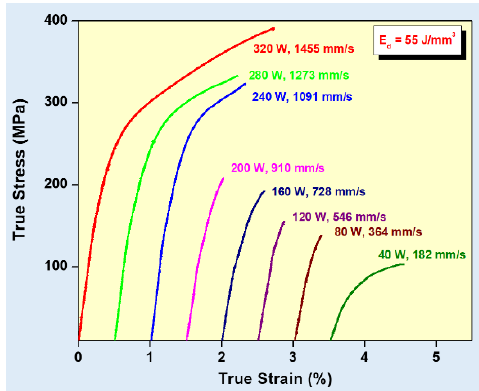
Figure 8. Room temperature tensile true stress-true strain curves of Al-12Si samples fabricated at a constant energy density of 55 J/mm 3 with varying laser power and laser scan speed in an SLM Solutions SLM 250 device [68]. Copyright 2017. Adapted as per the open access policy of Taylor and Francis group (Figure 1a [68]).